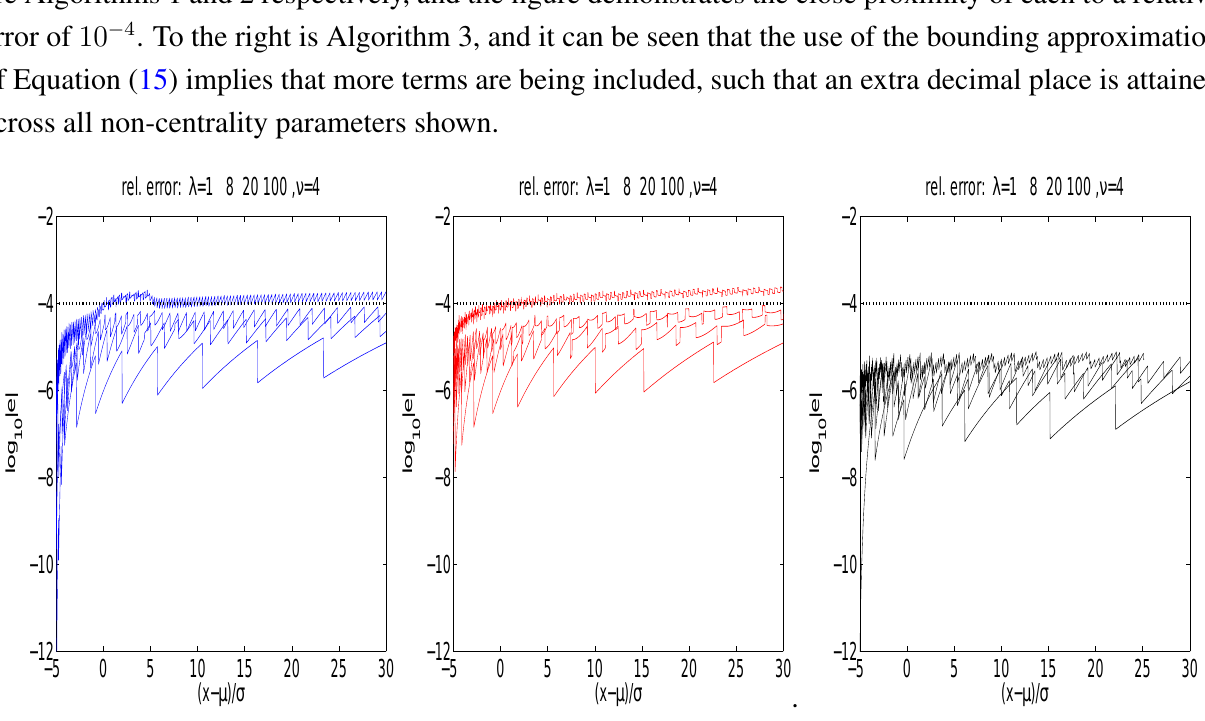
Figure 3. Left to right, the relative errors with B = 4 , for the three algorithms. Left, Algorithm 1 iterating starting from (cid:98) λ / 2 (cid:99) . Center, Algorithm 2 iterating from n ∗ . To the right, Algorithm 3 iterating from n ∗ and with the index set computed a priori